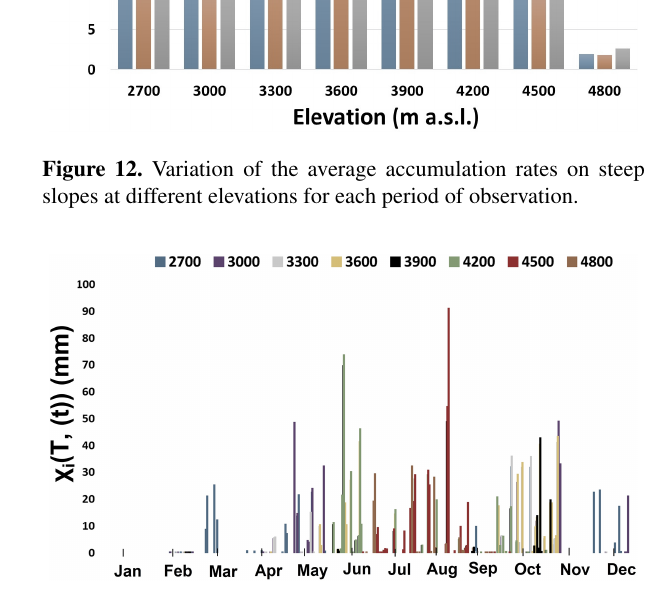
Figure 13. Accumulation (steep slopes) trends for the year 2019 at different